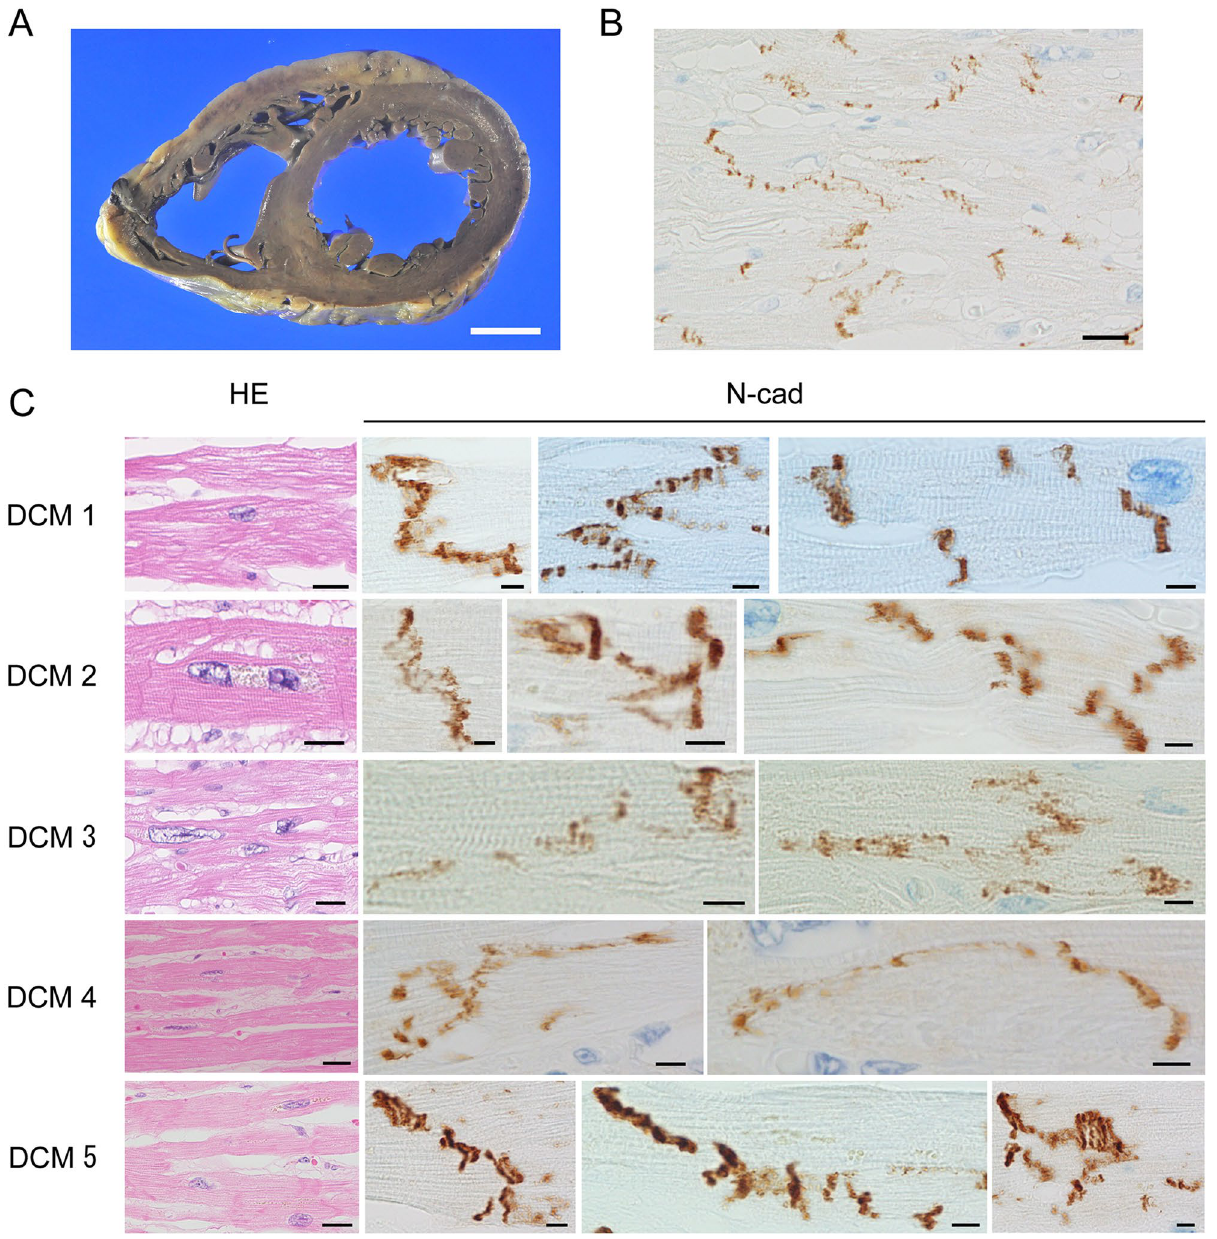
Figure 1. Pathological and immunohistochemical findings in dilated cardiomyopathy. ( A ) Macroscopically, we observed severe dilation of the bilateral ventricles. LV wall thickness in the DCM group was relatively uniform, but the wall was thinner in DCM than in the other two groups. ( B ) ICDs were partially but not clearly observed, and cardiomyocyte units were unclear. (N-cadherin immunostaining; scale bar, 20 µm; original magnification, × 400). ( C ) Characteristic findings of DCM included cardiomyocyte atrophy, nuclear pleomorphism, and interstitial fibrosis ( H – E staining; scale bar, 20 µm; original magnification, × 400). Immunohistochemistry revealed that N-cadherin immunostaining was lower in the DCM group than in the CHF and control groups (N-cadherin immunostaining; scale bar, 5 µm; original magnification, × 1000). ICD width was approximately 2–8 sarcomeres and was significantly elongated in the long-axis direction of the cardiomyocytes. The ICDs were scattered, had a stepwise shape, and were highly